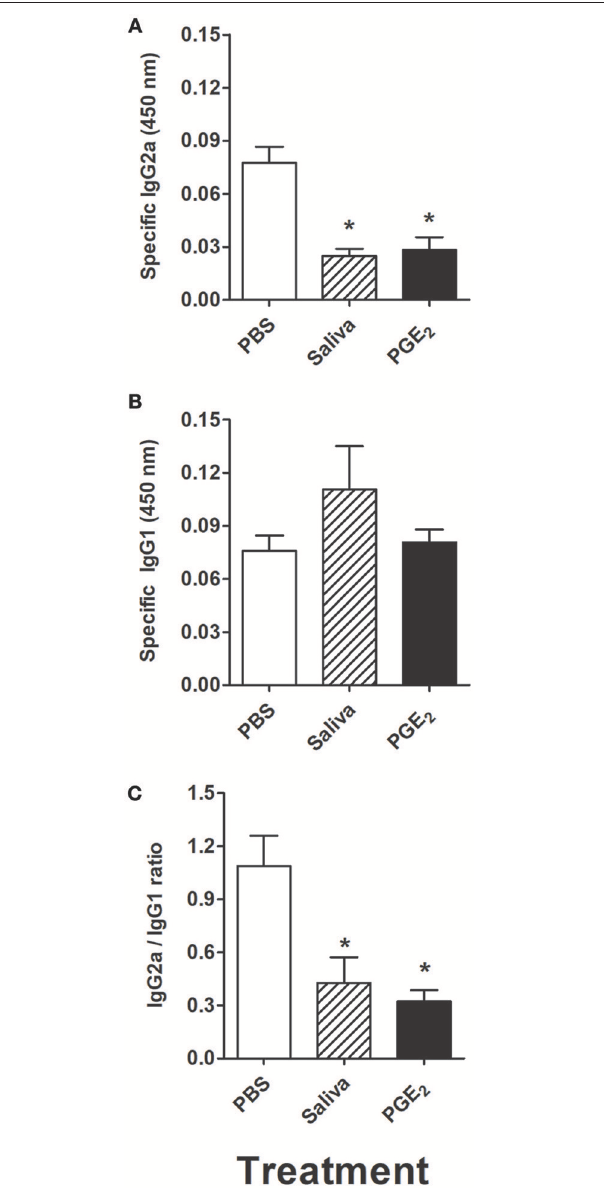
FIGURE 6 | Adoptive transfer of murine DCs incubated with R. rickettsii and treated with A. sculptum saliva or PGE 2 does not change IFN- γ or IL-4 recall response of spleen cells following antigenic restimulation in vitro . Bone marrow cells from C3H/HePas mice were differentiated into DCs, seeded at 10 6 cells/well in 24-well plates and preincubated for 1h with medium only, A. sculptum saliva collected by pilocarpine stimulation from female ticks fed on host for 7–9 days (1:50 dilution) or PGE 2 (100nM). Cells were incubated with R. rickettsii (10 7 bacteria) during 18h, collected and washed to remove unbound bacteria. Mice were injected subcutaneously with 10 6 DCs of each group in a 100 µ L volume. During the first 5 days after DC transfer, animals of each group received a subcutaneous treatment (100 µ L at the same site of DC inoculation) as follows: PBS, A. sculptum saliva (1:50 dilution) and PGE 2 (100nM). After 30 days of DC transference, the spleen was collected and the cells were restimulated with medium or HKRr for 72h. The levels of IFN- γ (A) and IL-4 (B) were evaluated in cell-free supernatant of cultures by ELISA. The IFN- γ /IL-4 ratio is also presented (C) . Results are expressed as the mean ± SEM. * p ≤ 0.05 vs. “DC + R. rickettsii /PBS” group.